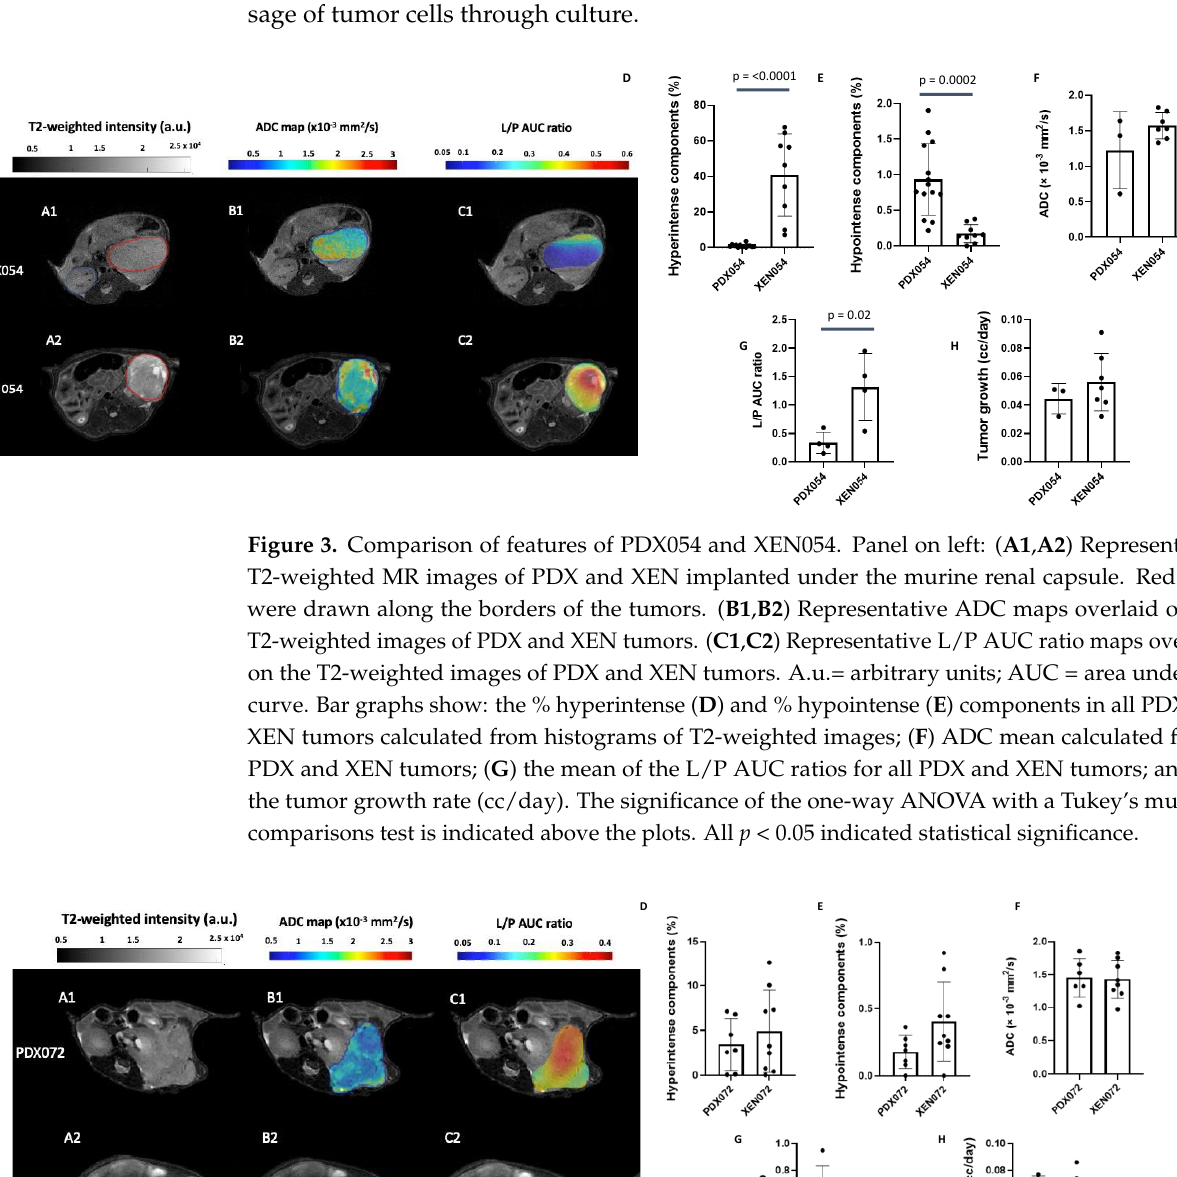
Figure 4. Comparison of features of PDX072 and XEN072. Panel on left: ( A1 , A2 ) Representative T2-weighted MR images of PDX and XEN implanted under the murine renal capsule. Red lines were drawn along the borders of the tumors. ( B1 , B2 ) Representative ADC maps overlaid on the T2-weighted images of PDX and XEN tumors. ( C1 , C2 ) Representative L/P AUC ratio maps overlaid on the T2-weighted images of PDX and XEN tumors. a.u.= arbitrary units; AUC = area under the curve. Bar graphs show: the % hyperintense ( D ) and % hypointense ( E ) components in all PDX and XEN tumors calculated from histograms of T2-weighted images; ( F ) ADC mean calculated for all PDX and XEN tumors; ( G ) the mean of the L/P AUC ratios for all PDX and XEN tumors; and ( H ) the tumor growth rate (cc/day). The significance of the one-way ANOVA with a Tukey’s multiple comparisons test is indicated above the plots. All p < 0.05 indicated statistical